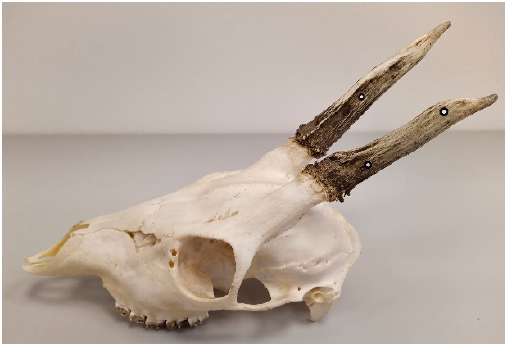
Figure 2. Location of reference points on roe deer antlers ( Capreolus capreolus ), the same location on the opposite